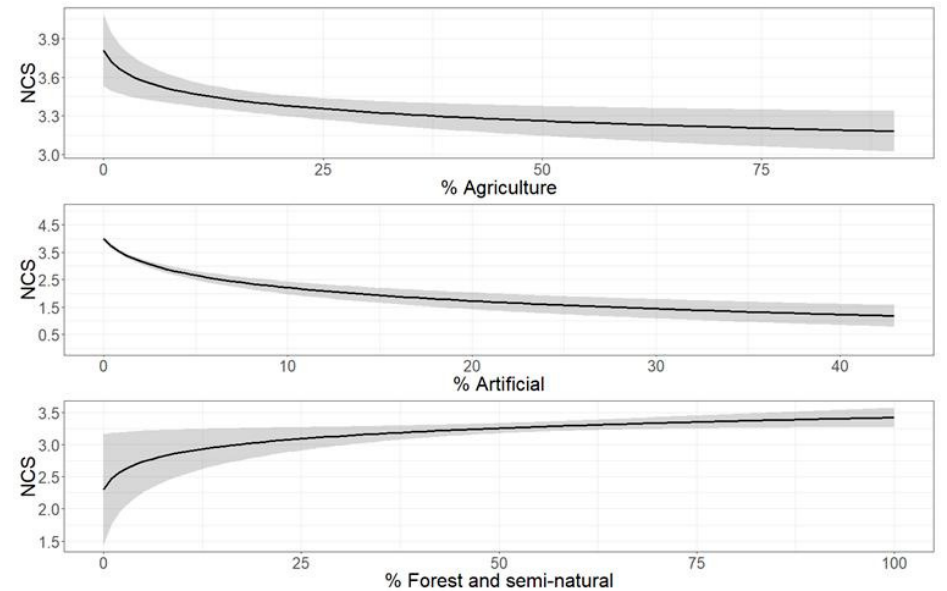
Figure 10. Predicted values of NCS to Agriculture, Artificial and Forest and semi-natural land uses.